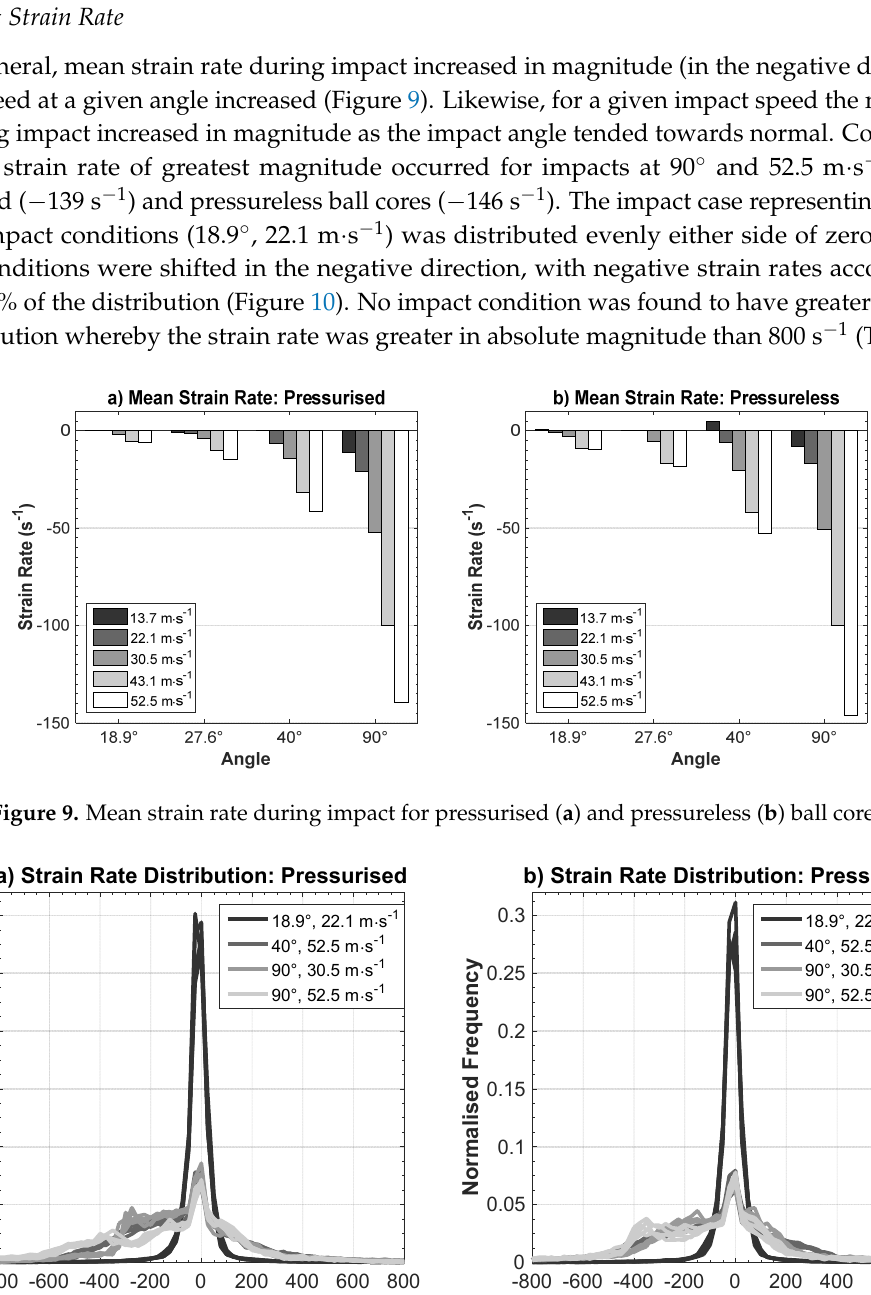
Figure 8. Strain distribution during impact for pressurised ( a ) and pressureless ( b ) ball cores.